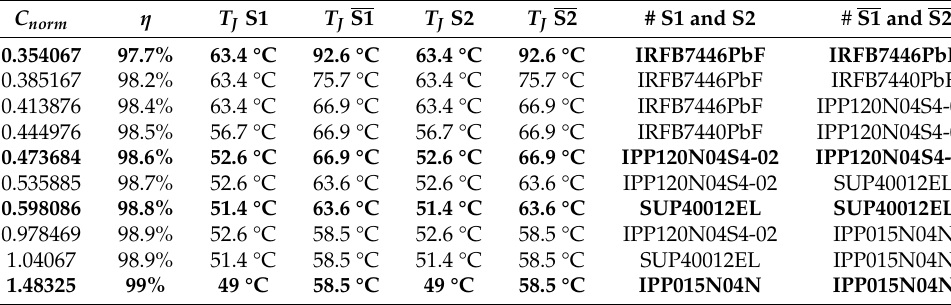
Table 4. Design details for DM with 800